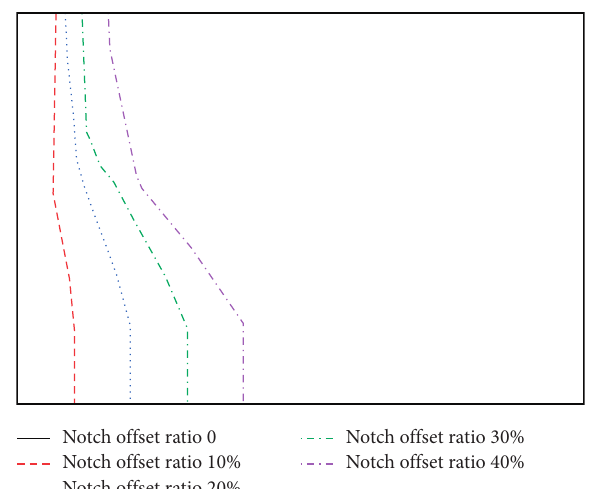
Figure 8: The crack length developments with the loading dis- placement increasing for different notch offset ratios.